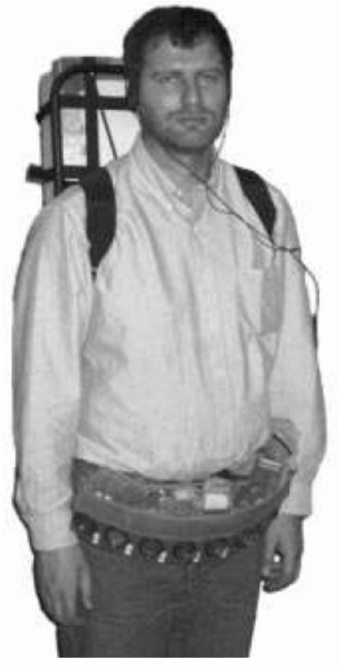
Figure 5. NavBelt